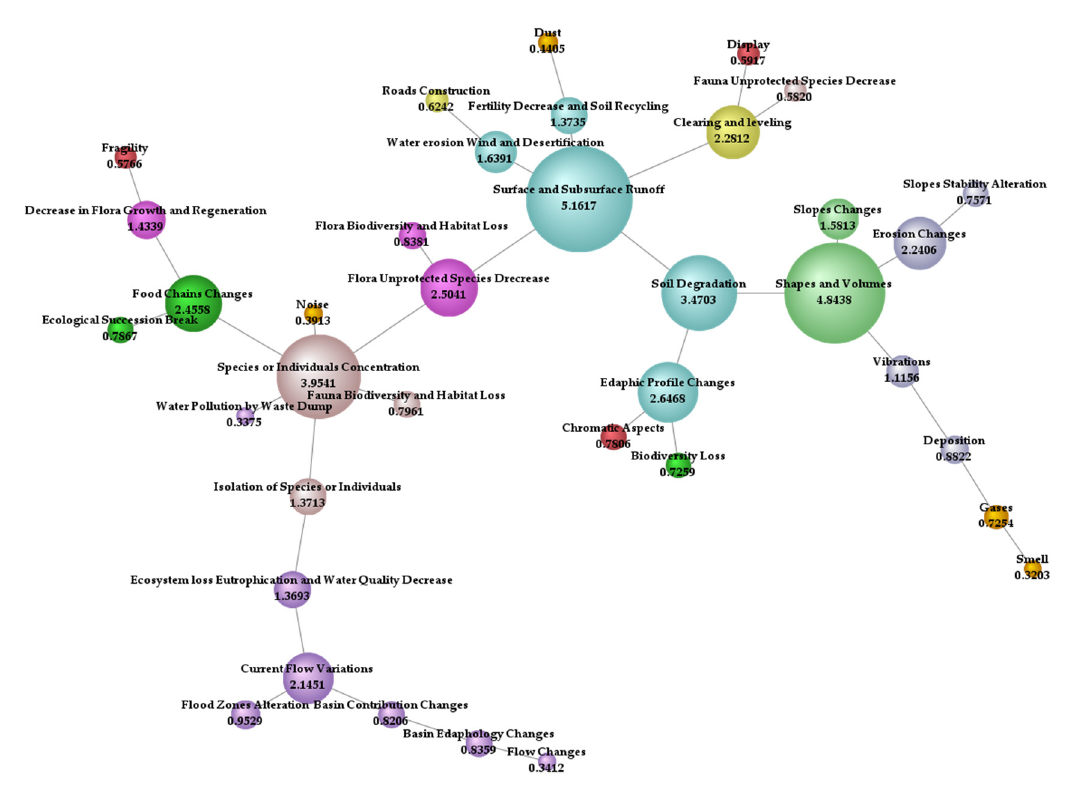
Figure 2. Unsupervised Bayesian network using node force mapping for the complete EIA representation. The color of the nodes outlines a conceptual clustering (human-based).